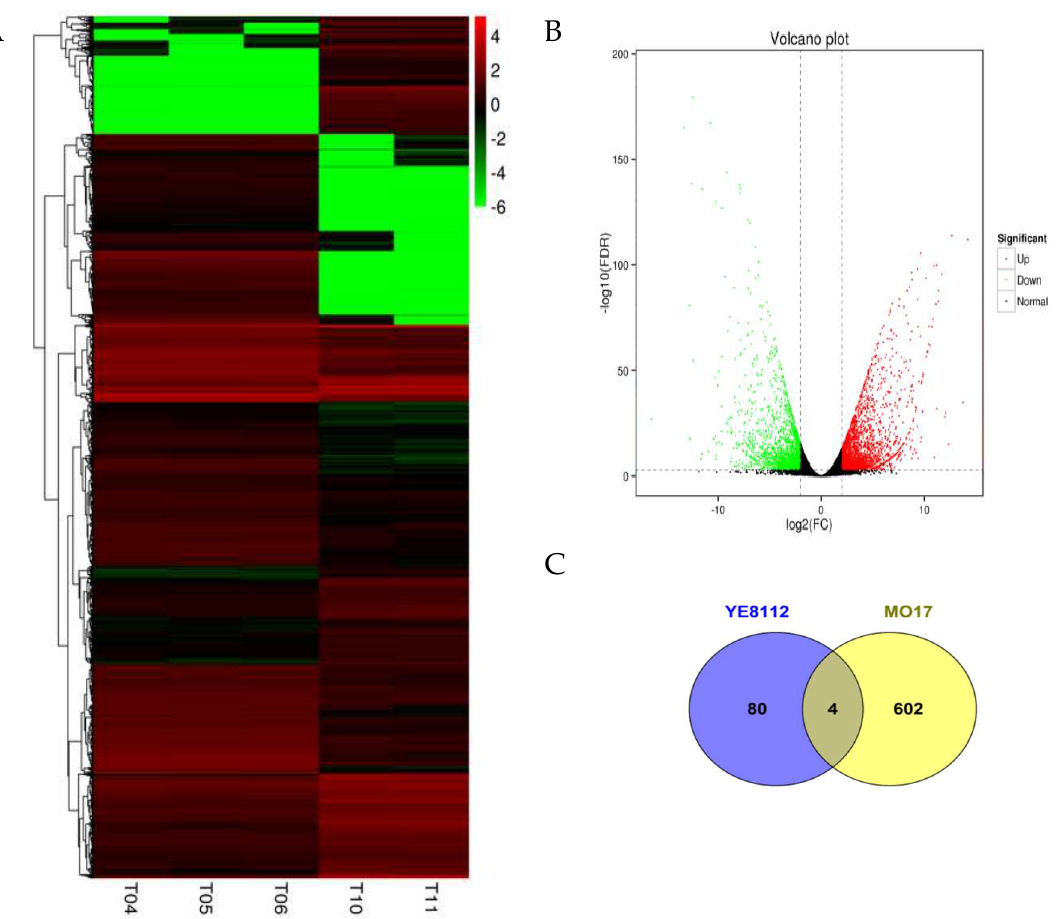
Figure 3. Clustering analysis of differentially expressed genes (DEGs) and number of DEGs in YE8112 and MO17. ( A ) Clustering analysis of DEGs in the inbred lines after drought stress treatment (SD_TD). The x -axis represents different samples. T04, T05, and T06 refer to the three replicates of tolerant line YE8112 drought stressed (TD); T10 and T11 refer to the two replicates of the sensitive MO17 drought stressed (SD); and the y -axis represents the differential genes expressed. The scale bar indicates up-regulated (red) and down-regulated (green) DEGs. The darker the color, the higher the expression, while the lighter the color, the lower the expression; G=genes of the same expression pattern are clustered together; ( B ) volcano plot showing the (log2 FC, − log10 FDR) expression of the DEGs in the SD_TD experimental comparison; ( C ) number of DEGs in drought stressed YE8112 and MO17 seedlings. The overlapping section of the Venn diagram shows the DEPs common to YE8112 and MO17 seedlings under drought stress conditions.